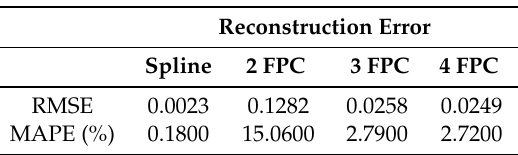
Table 3. MAPE and RMSE for the reconstruction step using 59 splines, and 2, 3 or 4 functional principal